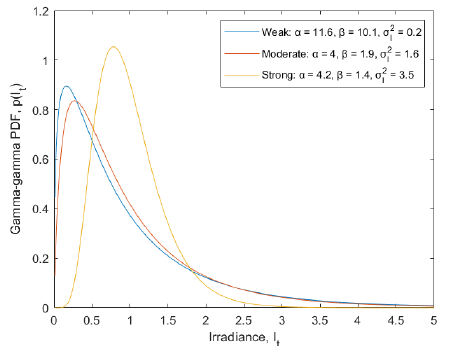
Figure 3. Gamma-gamma probability density function for three different turbulence regimes, weak, moderate, and strong with different , , and 2